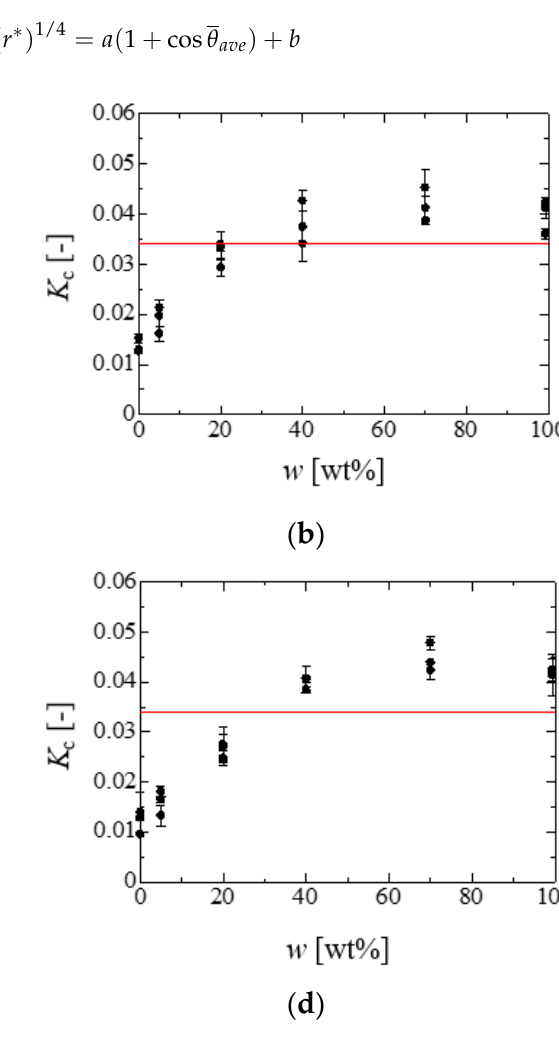
Figure 4. Splashing condition K c calculated by Equations (1) and (2) in each liquid: ( a ) bare substrate; ( b ) #400 substrate; ( c ) #240 substrate; and ( d ) #120 substrate. The splashing occurrence is defined by K c 0.034 (red solid line) [28,29]. The error indicates two standard deviation (2SD).